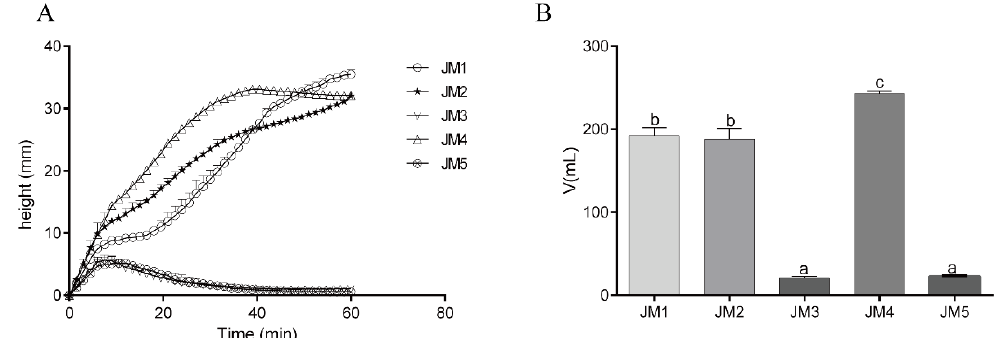
Figure 4. ( A ) Gas release curve. ( B ) Total CO 2 production of dough. The inocula used for dough fermentation were abbreviated as follows: JM1, Torulaspora delbrueckiiJM1. JM2, Pichia anomalaJM2, JM3, Issatchenkia orientalisJM3. JM4, Saccharomyces cerevisiaeJM4. JM5, Saccharomyces cerevisiaeJM5. Bars that do not share a common lowercase letter differ significantly ( p < 0.05) ( n = 3).